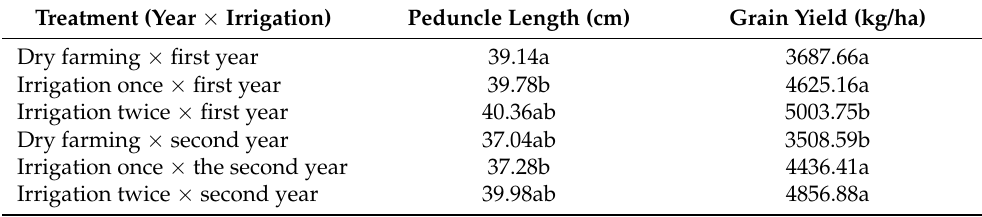
Table 3. Mean comparisons of the dual interactions of Years and cultivars on some traits. Treatment (Year × Cultivars) Plant Height (cm) Awn Length (cm) Seed/Spike first year × Sardari